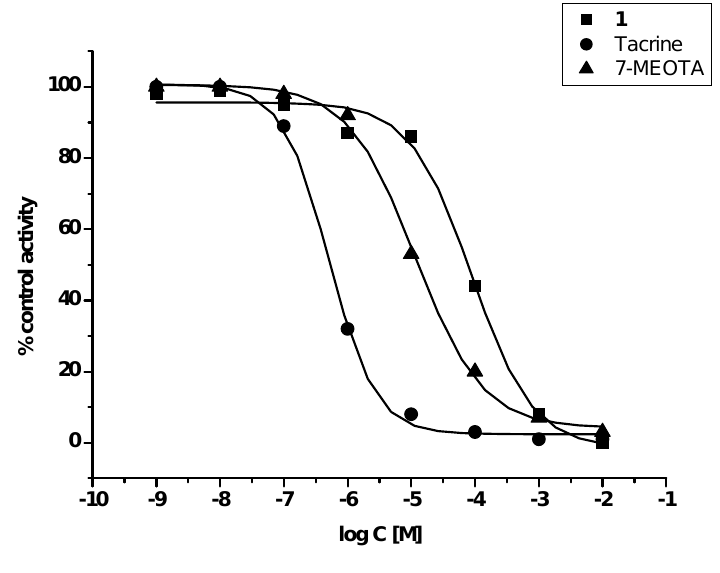
Figure 2. Enzyme activity plot of 1 , THA and 7-MEOTA for hAChE.